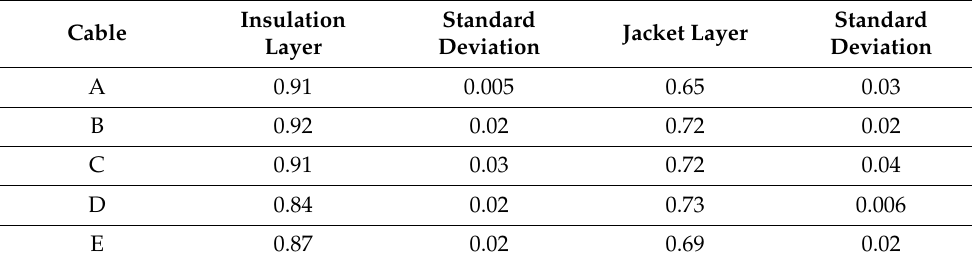
Table 6. Crosslink fractions for insulation and jacket